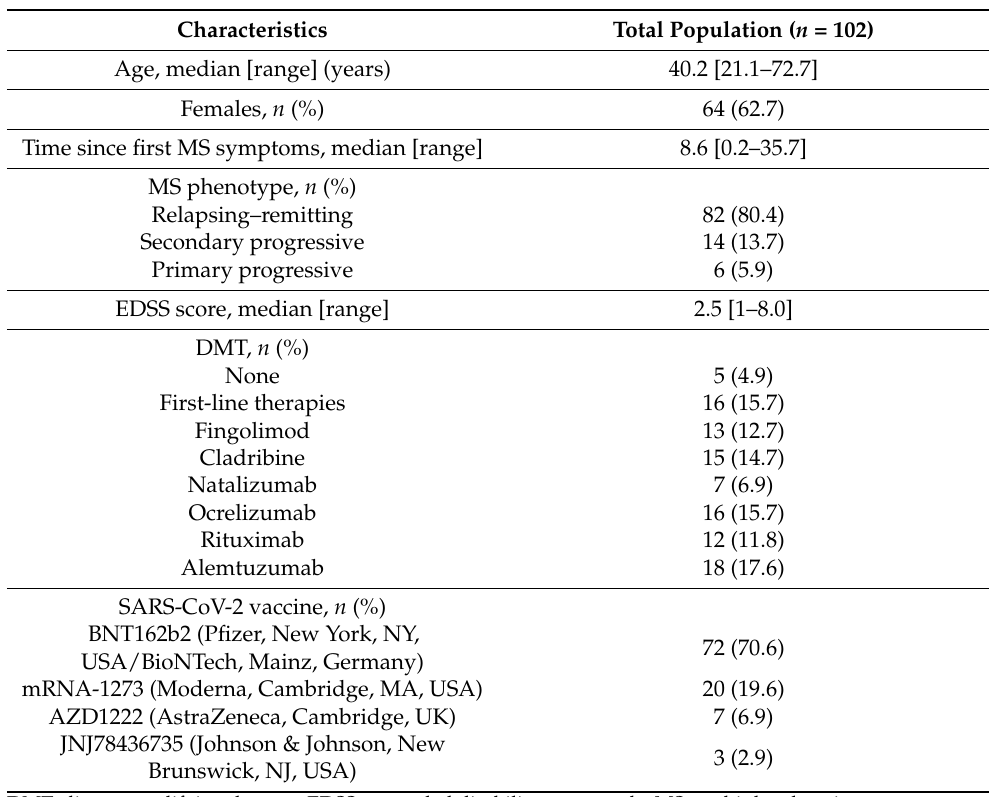
Table 1. Demographic and clinical characteristics.